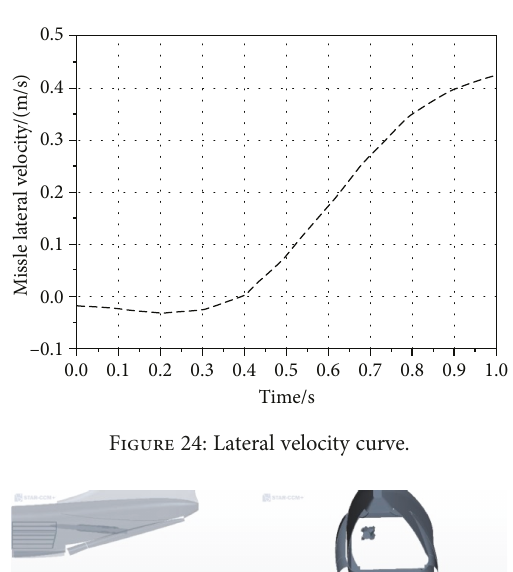
Figure 30: Missile movement posture at 1